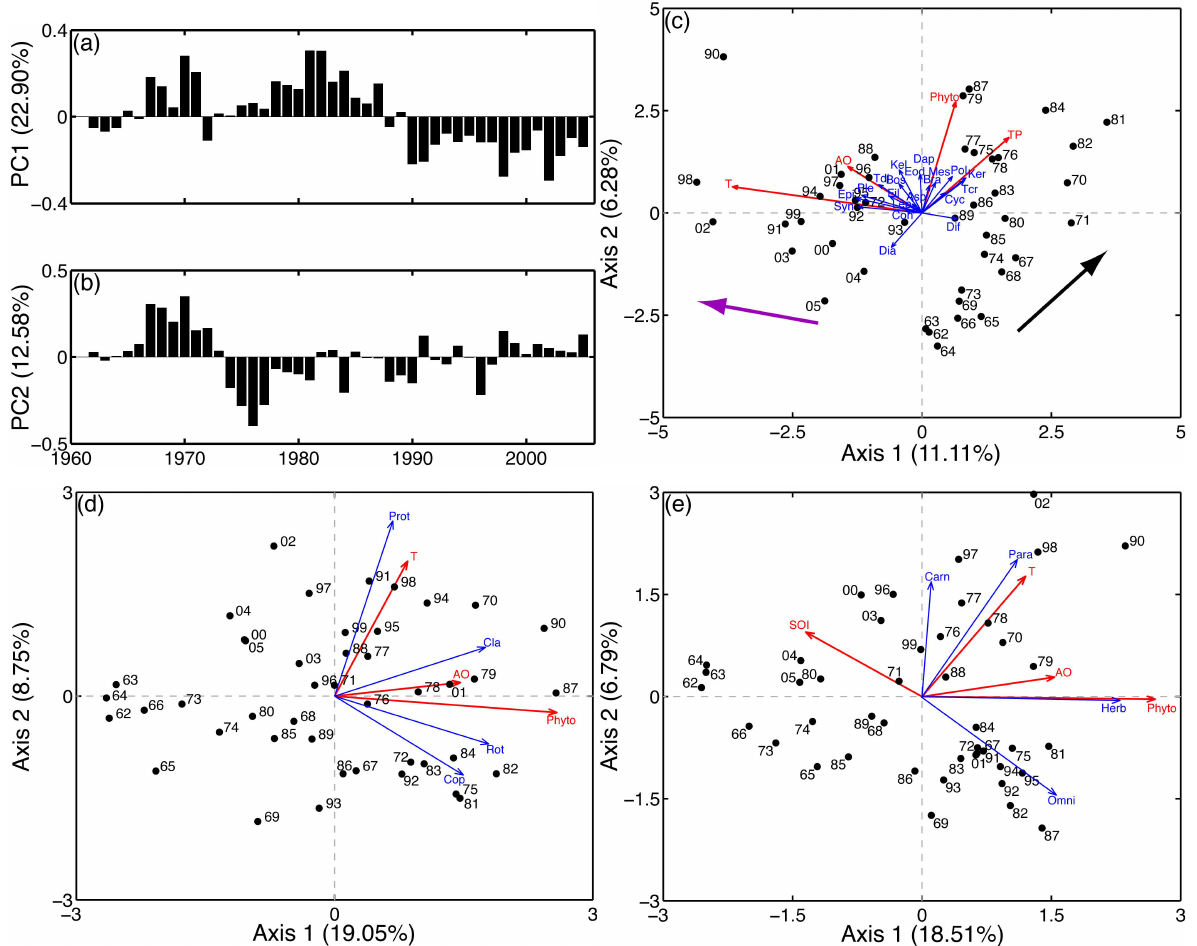
Fig. 5. Principal component analysis of dominant taxa ( a and b ), and biplot of redundancy analysis relating years and zooplankton taxa and depicting how environmental factors affected the zooplankton community dynamics ( c–e ). The analyses were based on data at (c) genus level, (d) aggregated higher taxonomic groups, and (e) aggregated feeding types. In (c) , the black arrow indicates a gradient of increased eutrophic status, and the purple arrow indicates a warming gradient. In (d) and (e) the gradient of increased eutrophic status and warming is less